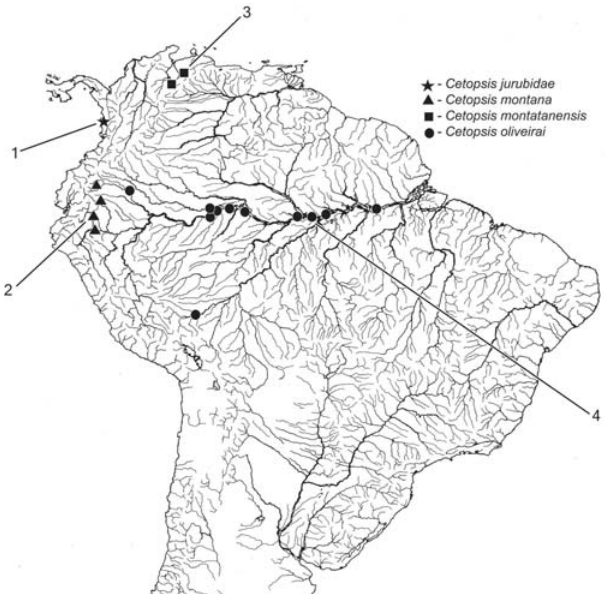
Fig. 25 . Map of central and northern South America showing geographic distribution of Cetopsis jurubidae (1 = holotype lo- cality of Pseudocetopsis jurubidae ), Cetopsis montana (2 = holo- type locality), Cetopsis motatanensis (3 = holotype locality of Pseudocetopsis plumbeus motatanensis ), and Cetopsis oliveirai (4 = holotype locality of Bathycetopsis oliveirai ) (some symbols represent more that one locality and/or lot of Dorsal and anal fins shown with scattered, dark pigmenta- tion. Caudal fin with band of dark pigmentation on distal one- half but with fin margin less intensely pigmented and with dark band wider on dorsal lobe.